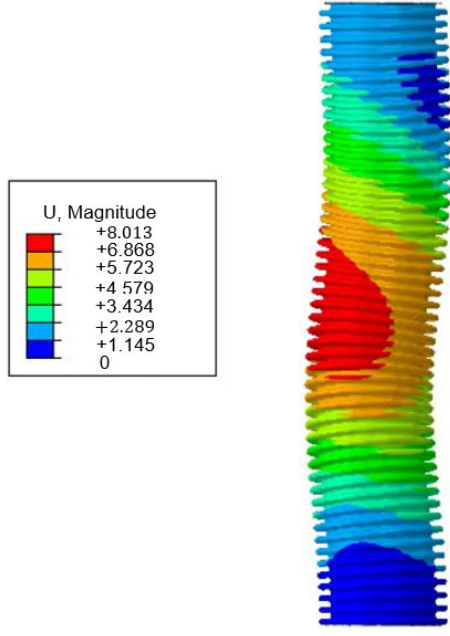
Figure 20. Post-buckling mode just at the critical torque value.